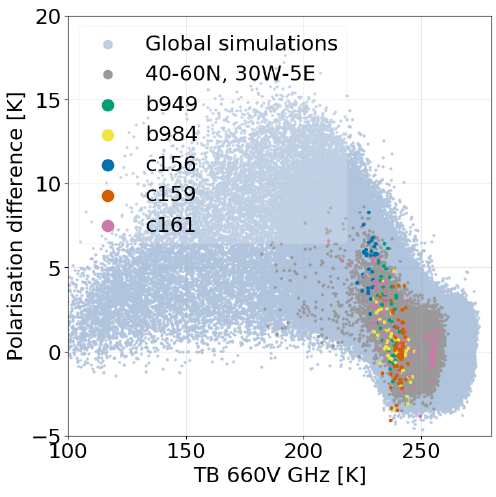
Figure 5. The scatter plot showing the PD vs. TB V at 660GHz. The light blue dots are near-global simulations; the grey dots denote simulations in 40 ◦ N–60 ◦ N/30 ◦ W–5 ◦ E. The five alphanumeric codes depict observations from the five flight campaigns described by Fox